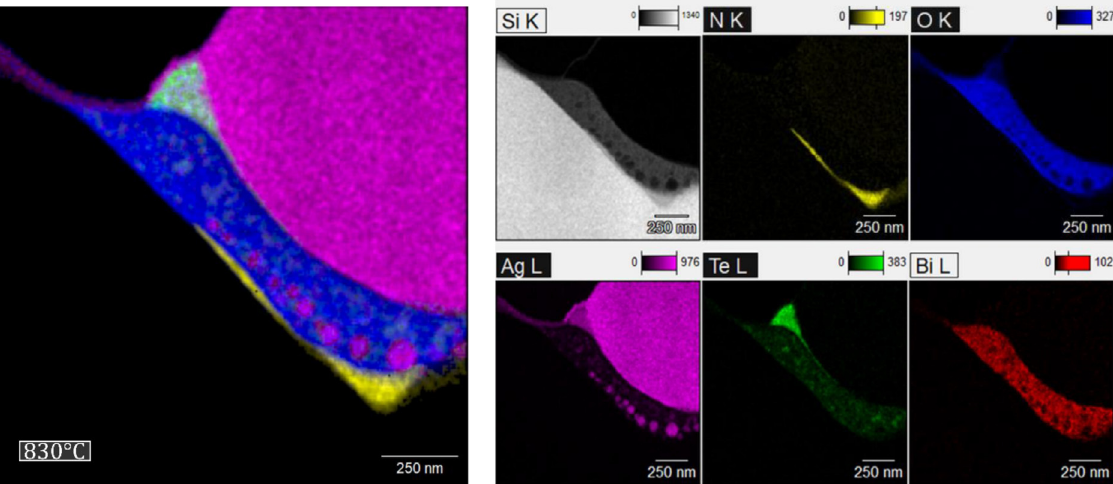
Fig. 8. EDX mapped cross section of a Si pyramid trough with Ag crystallite at the top, combined on the left, for each element respectively on the right. The Ag interspersed glass layer shows an example of a possible indirect contact via